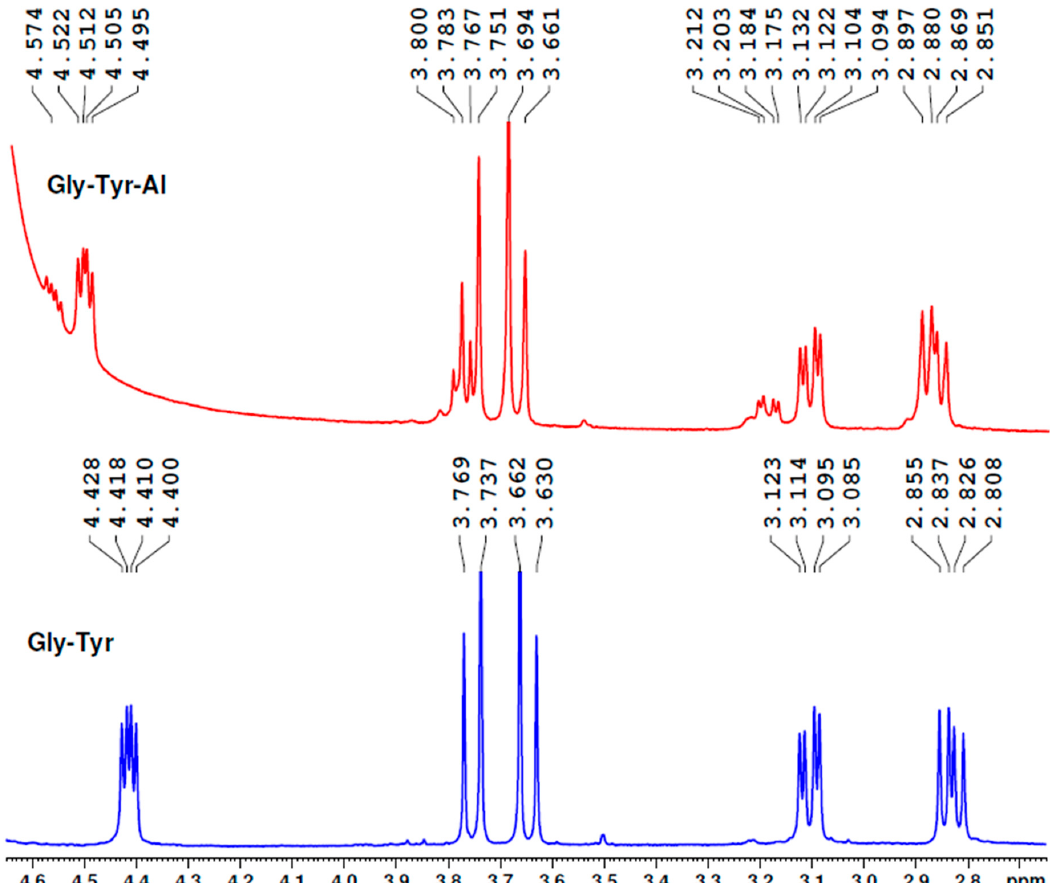
Figure 12. 1 H-NMR spectra of glycyl-tyrosine peptide, which demonstrate the influence of Al on the two protons of the tyrosine CH 2 group (3.085–3.123 ppm) and the two protons of the glycine CH 2 group (3.630–3.769 ppm).